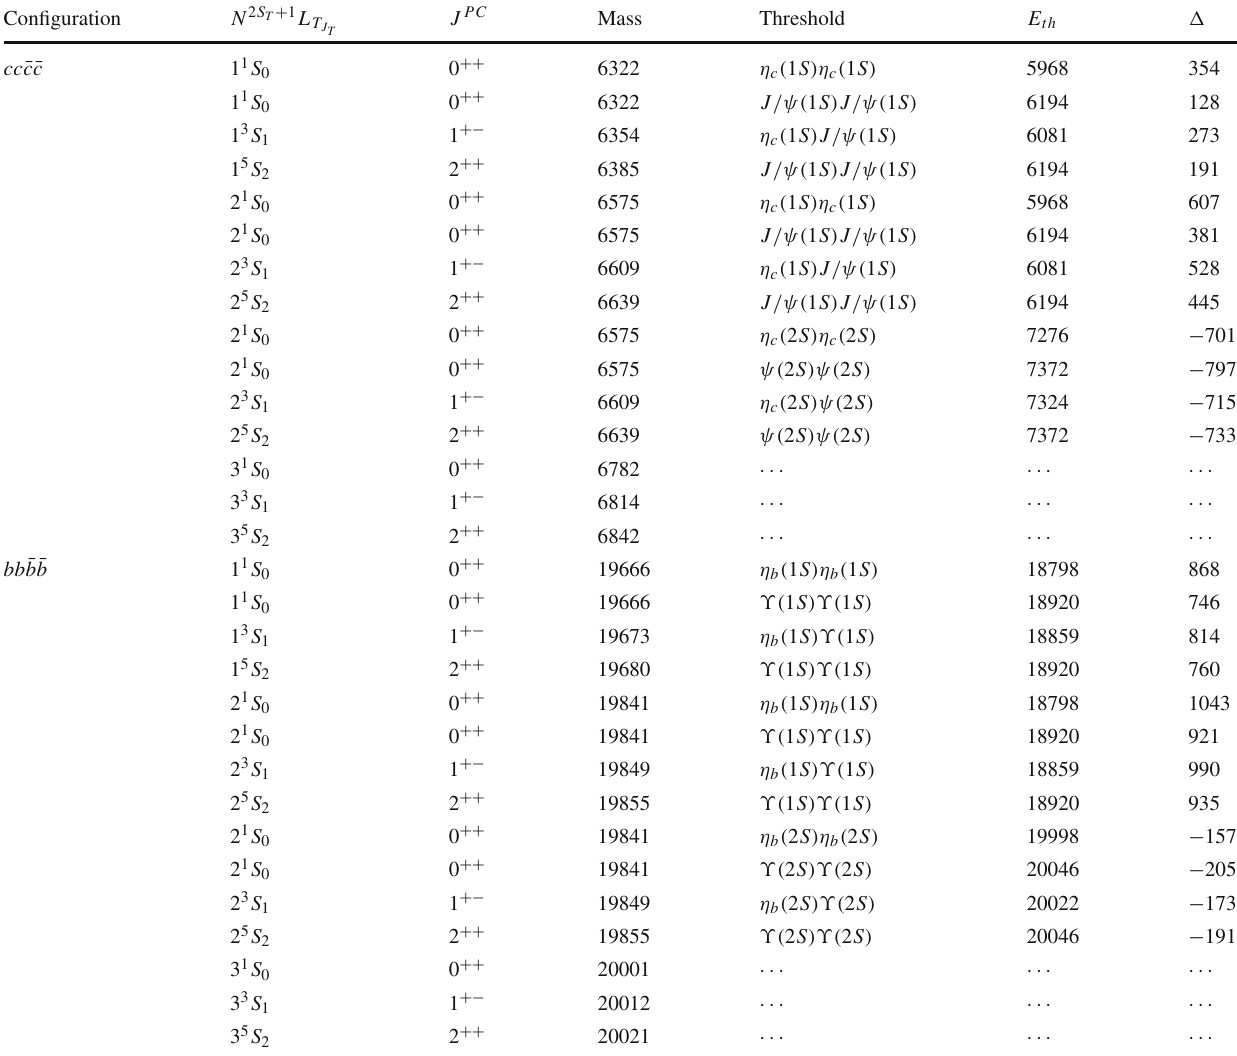
Table 7 Masses of ground, first, and second radially excited fully-heavy cc ¯ c ¯ c and bb ¯ b ¯ b tetraquark states. E th is the threshold mass of two heavy Q ¯ Q mesons. All results are given in